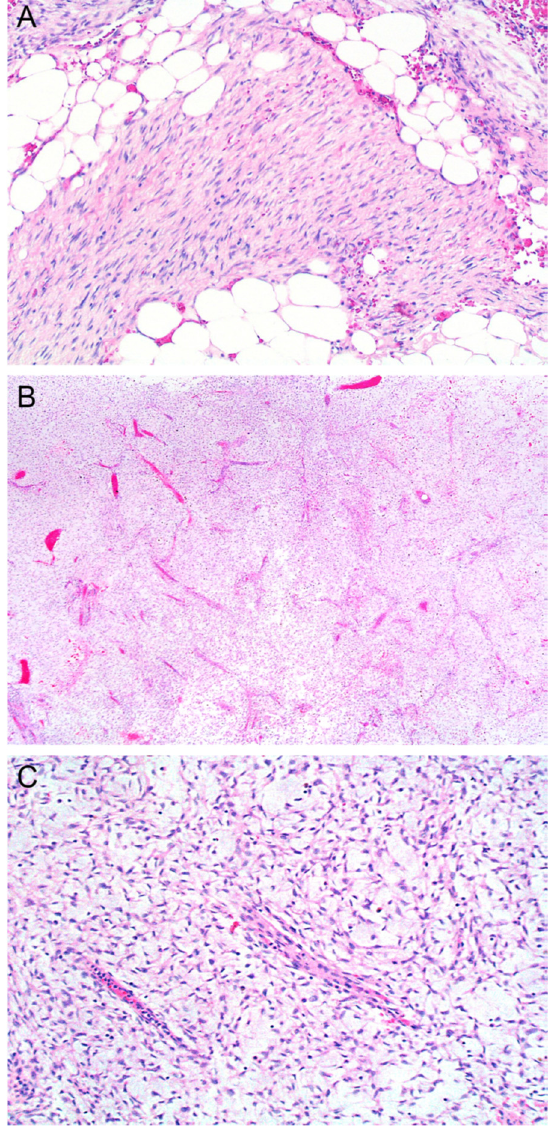
Figure 2. Myxoid DFSP. In this variant, characteristic storiform growth of DFSP is often lost, and the blood vessels are more prominent. However, honeycomb pattern of infiltration into subcutaneous fat can still be seen (( A ); magnification ×100 and ( B ); magnification ×40). Nuclei are plump, wavy, and uniform with focal or diffuse myxoid change (( C ); magnification ×100). Prominent myxoid stromal changes are observed in many benign and malignant mesenchymal neoplasms, which may be mistaken for myxoid DFSP, especially in small biopsy specimens. Neoplasms that may resemble myxoid DFSP include cutaneous myxoma, myxofibrosarcoma, low-grade fibromyxoid sarcoma, myxoid liposarcoma, superficial acral fibromyxoma, solitary fibrous tumor, and monophasic synovial sarcoma. Unlike DFSP, cutaneous myxoma is well circumscribed and does not infiltrate the underlying subcutis. In addition, cutaneous myxoma is negative for CD34 but positive for alpha-smooth muscle actin.